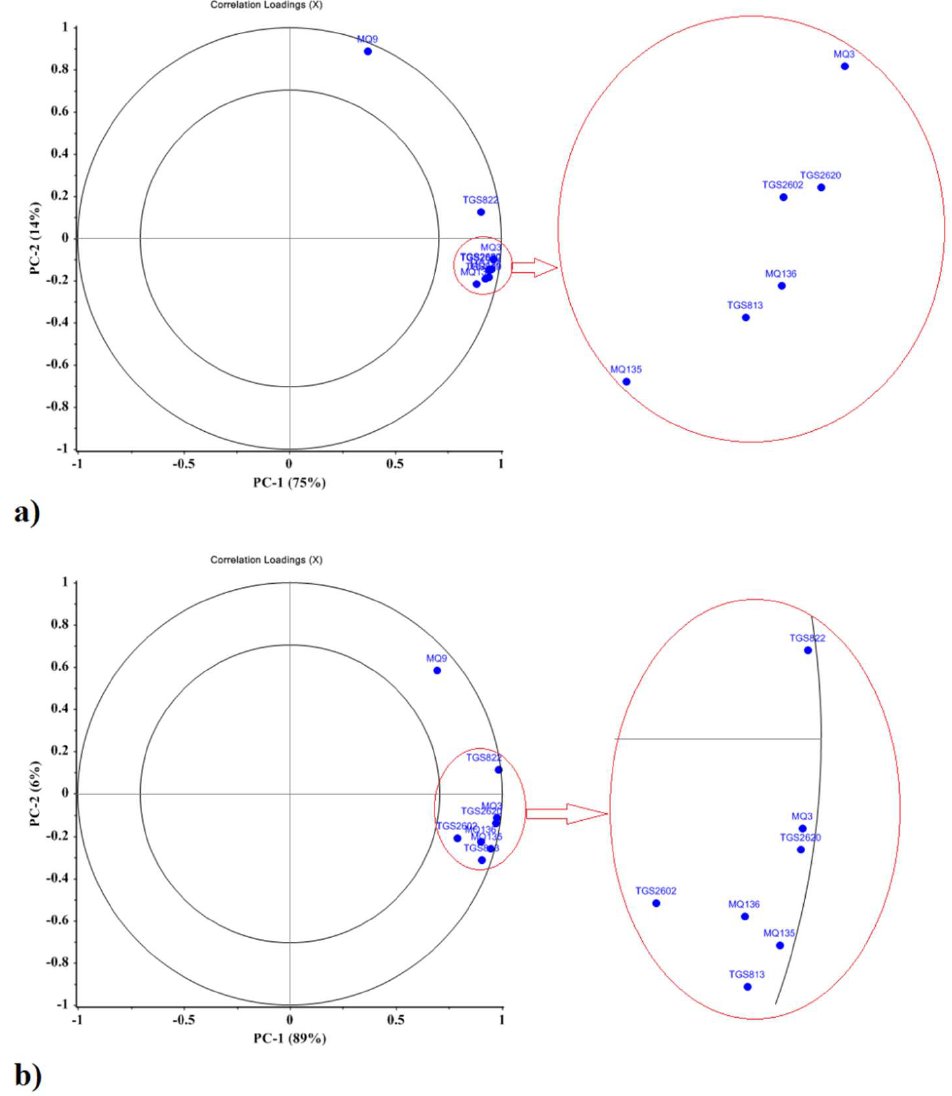
Figure 5. Loading plot for PCA analysis. Relative contribution of sensors for discriminations of hydrodistillation sample types for ( a ) mint EO, oil fraction, and ( b ) mint DWE, water fraction, determined from sensor array output data collected using the 8-sensor MOS e-nose.